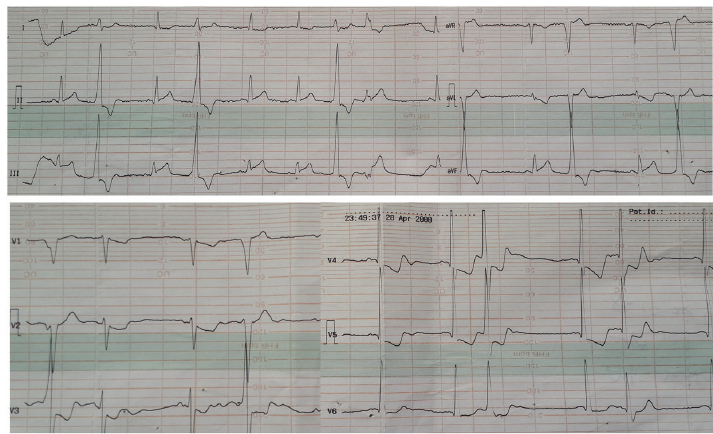
Figure 1: This electrocardiogram demonstrates ventricular premature beats and increased amplitude of the T-wave in inferior derivations.